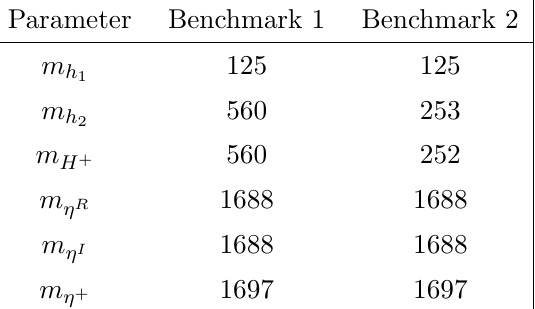
Table 3 . Scalar physical masses in GeV for the chosen benchmarks.